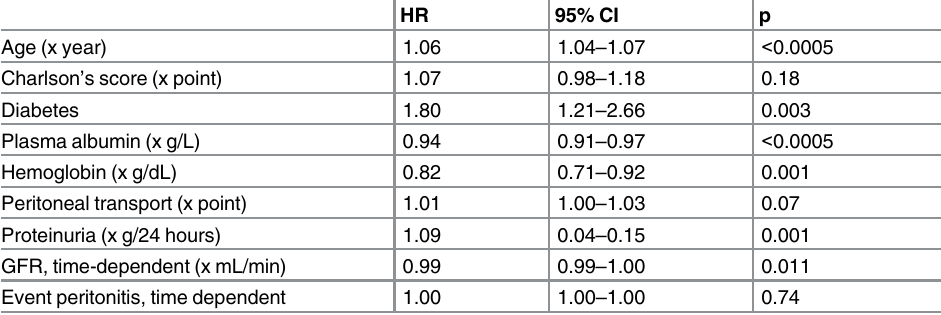
Table 5. Predictors of mortality of patients starting PD. Time-dependent multivariate analysis.